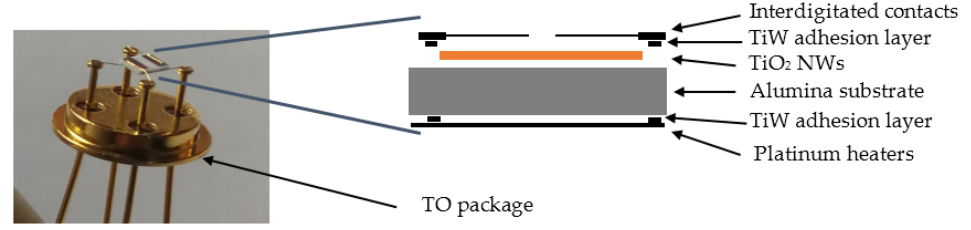
Figure 1. Schematic of the conductometric device fabricated.